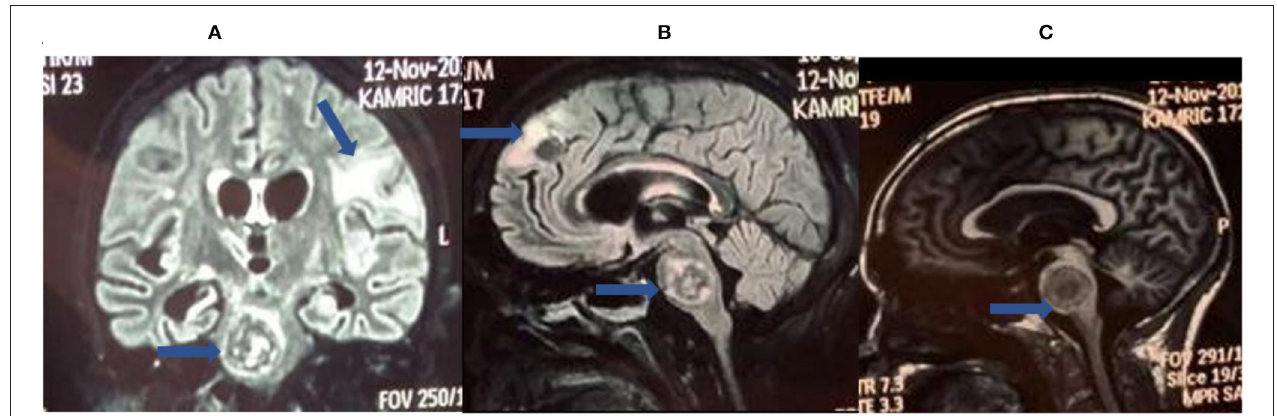
FIGURE 1 | Brain magnetic resonance imaging (MRI) for tuberculous meningitis (TBM) diagnosis. These are selected images from a brain MRI obtained from a patient with definite TBM showing cerebral space occupying lesions (tuberculomas) in the brainstem (A–C) and frontal lobe along with white matter ischemic changes (B)